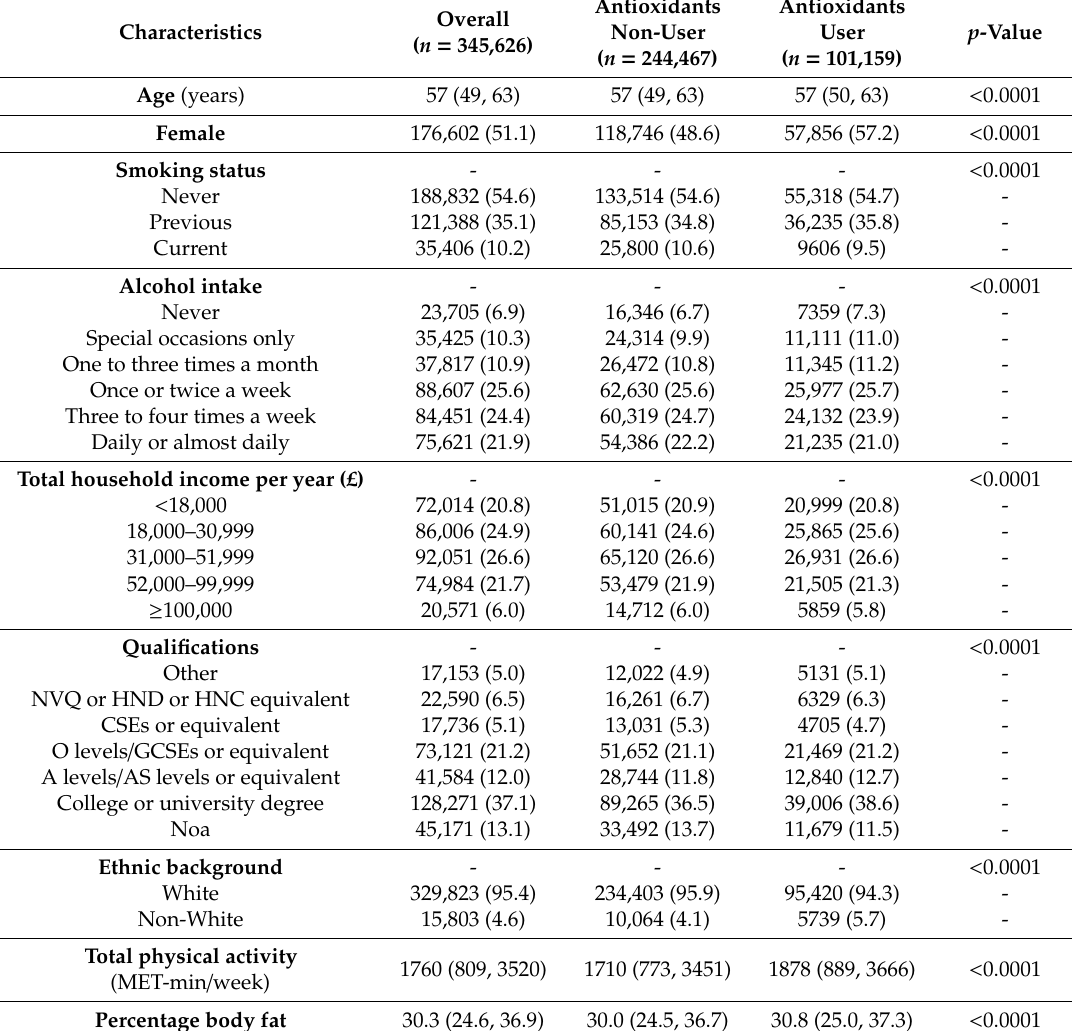
Table 1. Baseline characteristics of the UK Biobank cohort by antioxidants use.